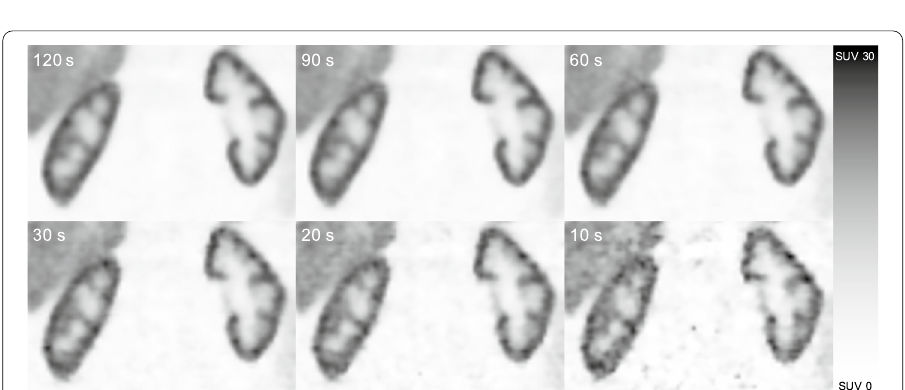
Fig. 2 Coronary images of the kidneys acquired at 2 h p.i. in a representative patient showing image quality at different acquisition durations per bp. Reducing acquisition duration results in more noise, which is visible, especially in the 20-s and 10-s images. bp: bed position, p.i.: